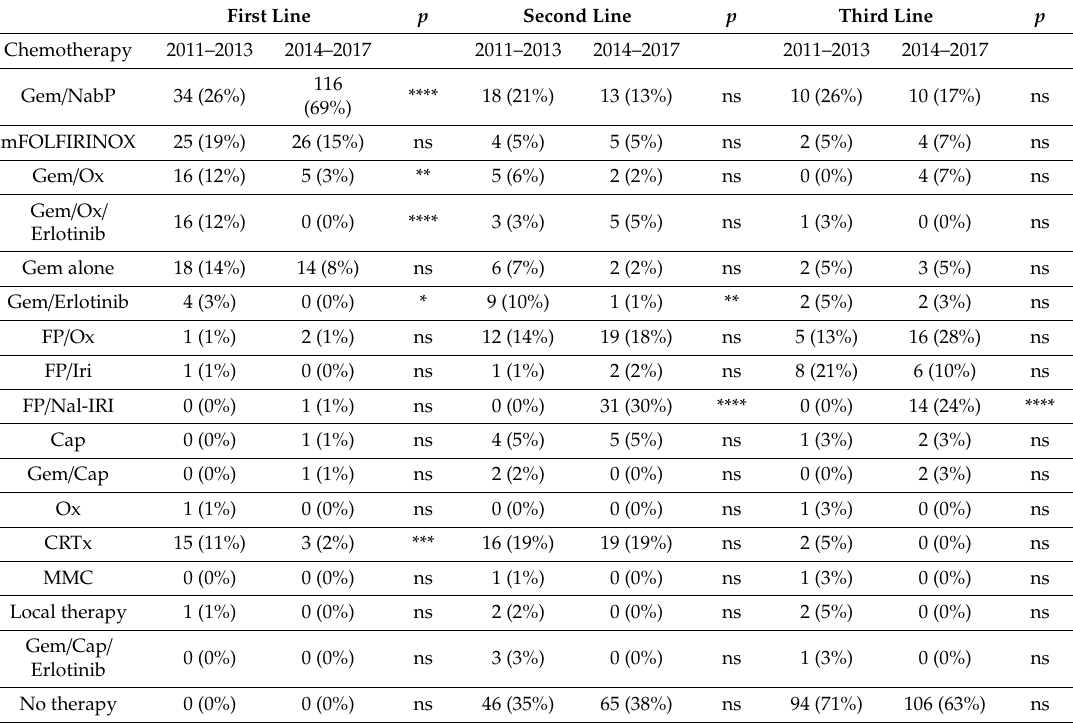
Table 2. Administered chemotherapy regimens.